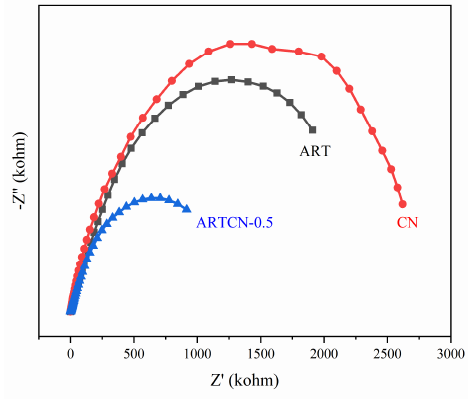
Figure 11. EIS spectra of the